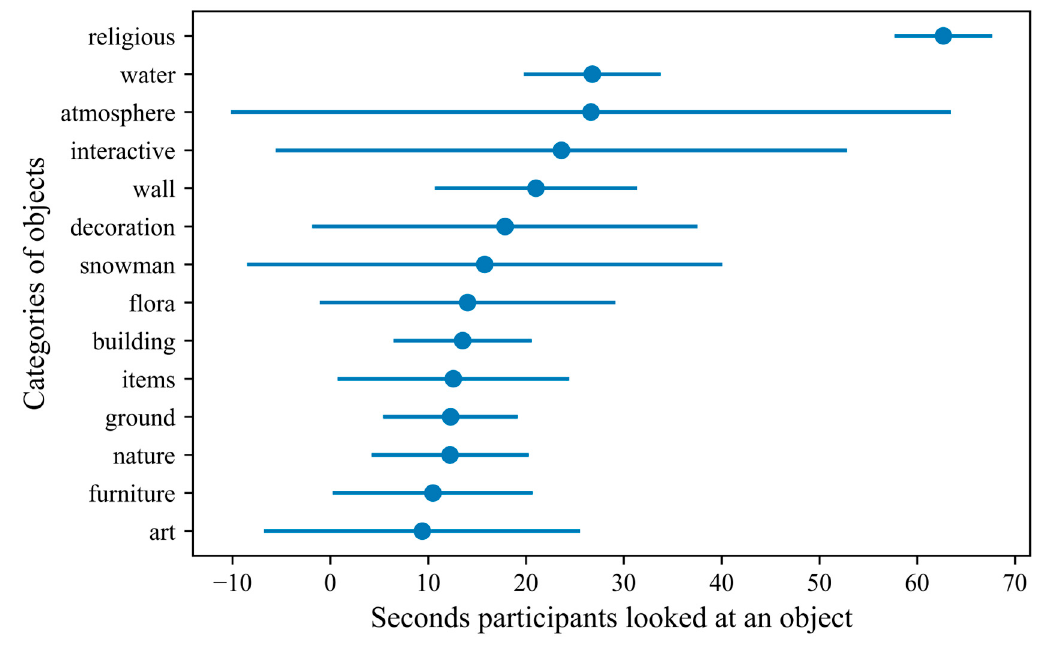
Figure 3. The thematic groups of objects participants fixated on, based on the average duration for each within the VEs (the error bars indicate standard deviation).